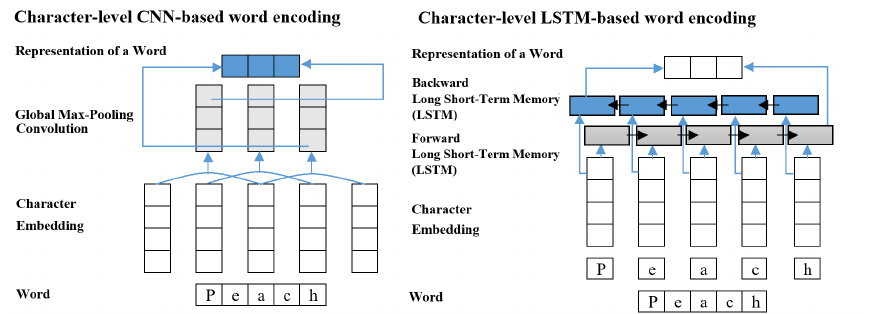
Figure 1. Character-level CNN or LSTM-based word